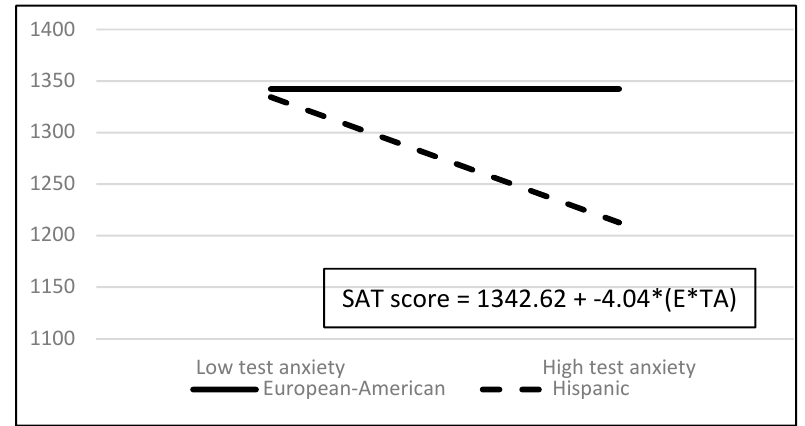
Figure 1. Overall SAT scores as a Function of the Ethnicity X Test Anxiety Interaction. E * TA = ethnicity X test anxiety interaction.